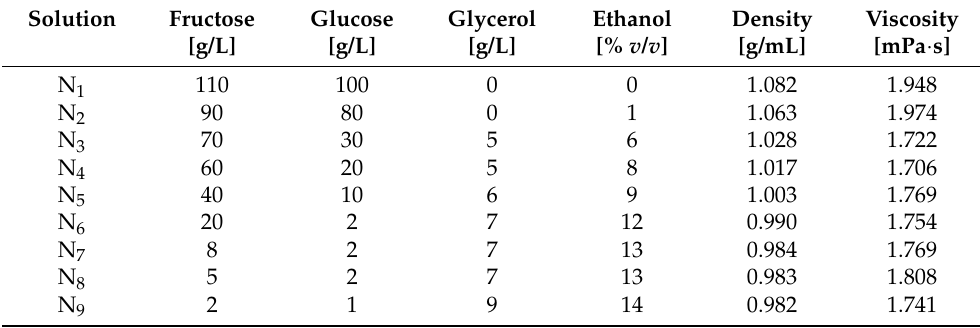
Table 4. Composition, density and viscosity (measured with the commercial instrument) of the model solutions that represent a normal fermentation process (N 1 :N 9